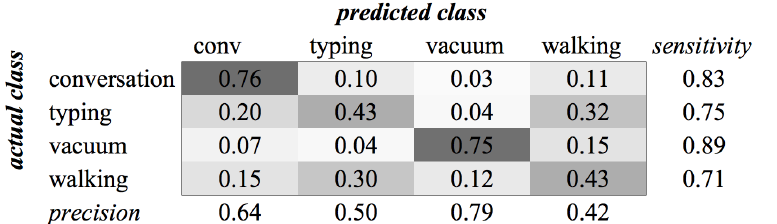
Figure 4. Classification of Category Office using SVM on MFCC features.